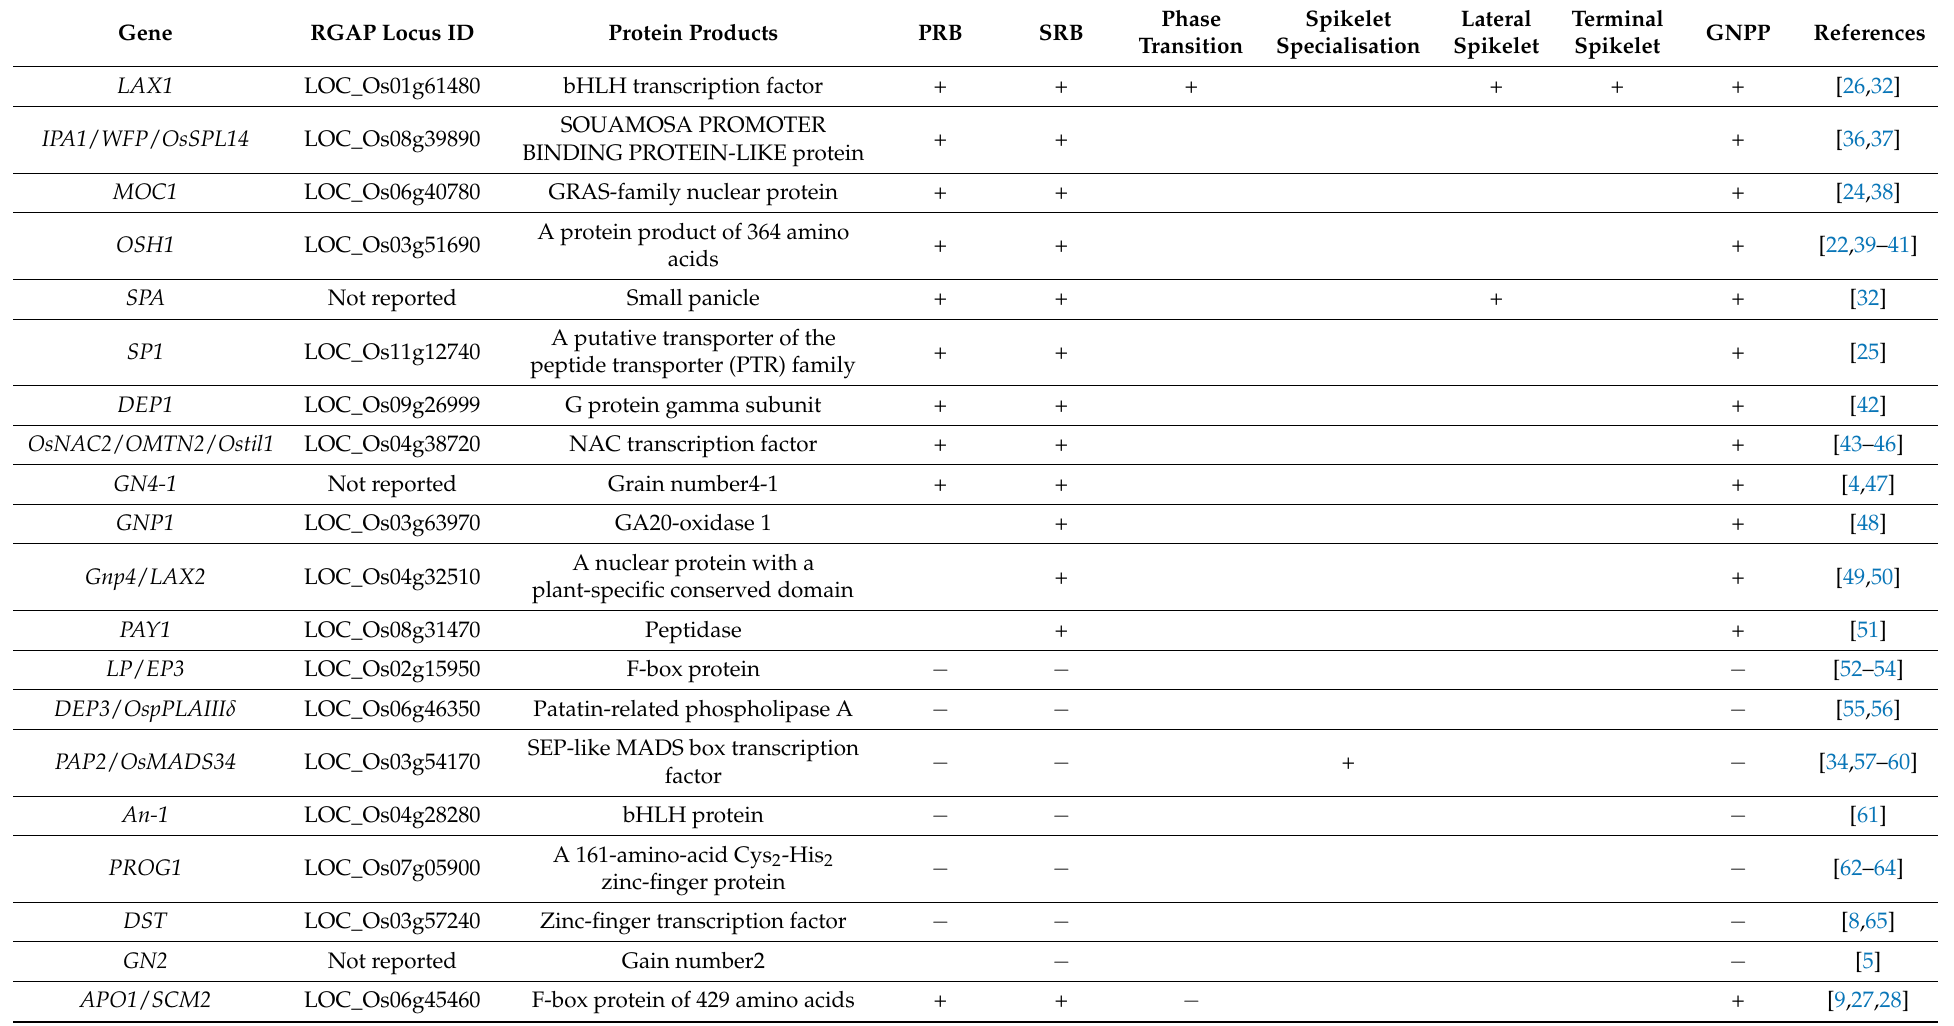
Table 1. GNPP-related genes and their regulation of GNPP. GNPP, grain number per panicle; Phase transition, from rachis branch meristem to spikelet meristem; PRB, primary rachis branch; SRB, secondary rachis branch; − , negative regulation; +, positive